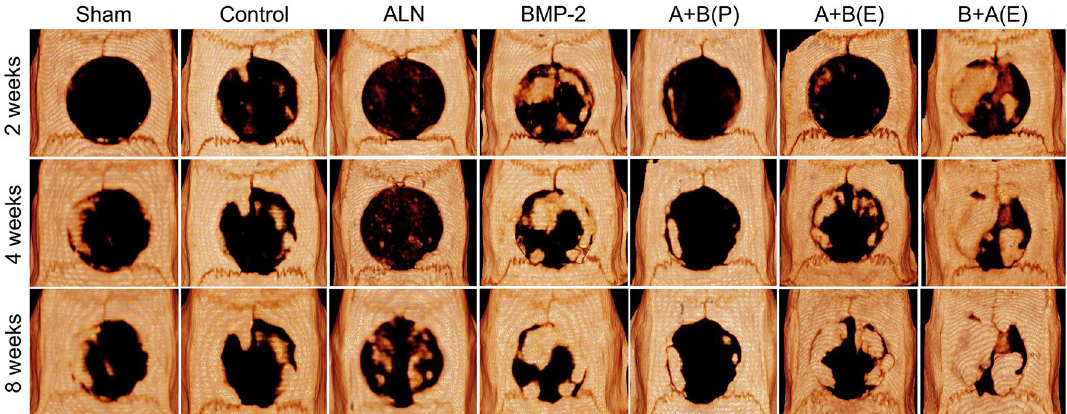
Figure 5. Micro-computed tomography-reconstructed images at 2, 4, and 8 weeks postoperatively. µ-CT radiographic images of rat calvarial bone formed at 2, 4, and 8 weeks postoperatively in different groups, showing degree and extent of mineral deposition at the defect site.